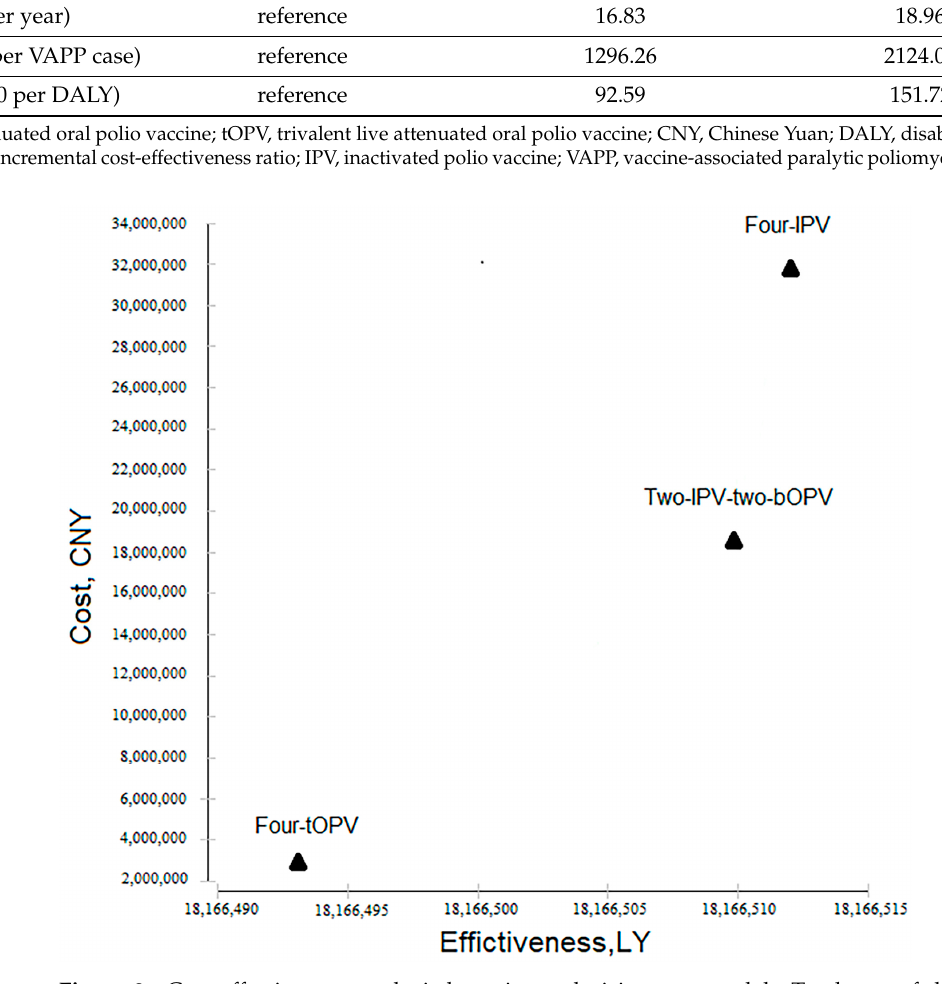
Figure 2. Cost-effectiveness analysis by using a decision tree model. Total cost of three polio immunization schedules in 2016 was used as the cost, and the sum of LY of local resident births in 2016 was used as the effectiveness. The four-tOPV immunization schedule was cost-effective; in contrast, both the two-IPV-two-bOPV schedule and the four-IPV schedule were cost-ineffective. bOPV, bivalent live attenuated oral polio vaccine; tOPV, trivalent live attenuated oral polio vaccine; IPV, inactivated polio vaccine; LY, life year.